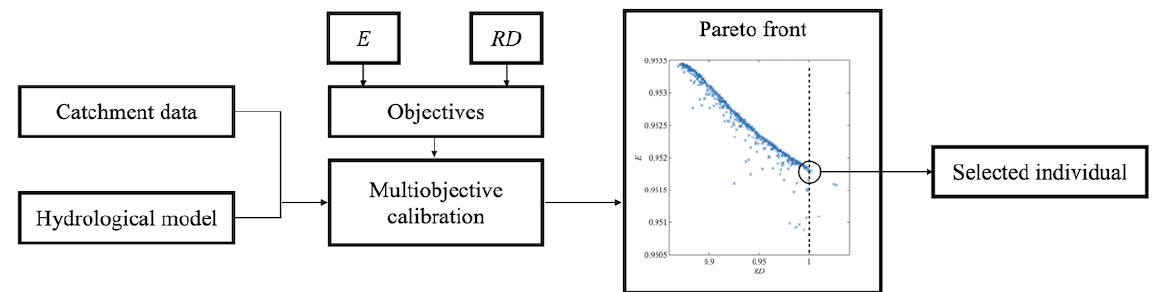
Figure 2. Flow chart of the E –RD